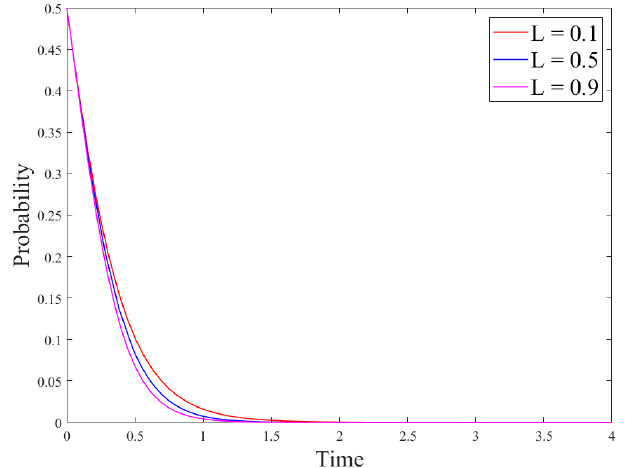
Figure 13. Evolution results of the government strategy. ( L : consumer acceptance of new products).